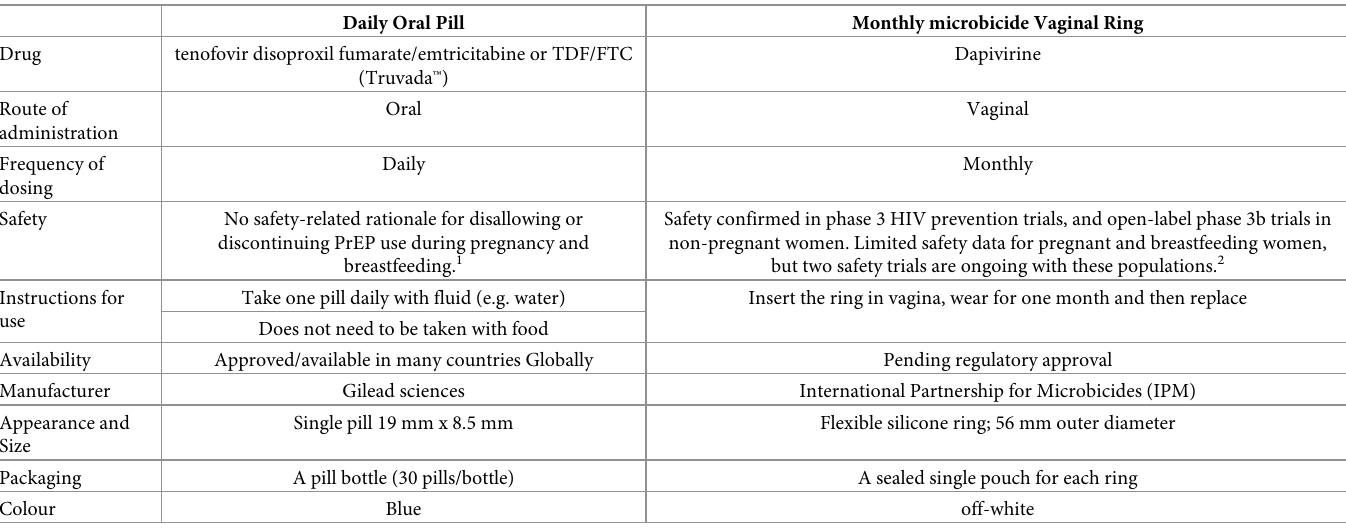
Table 1. Attributes of products for HIV Pre-Exposure Prophylaxis